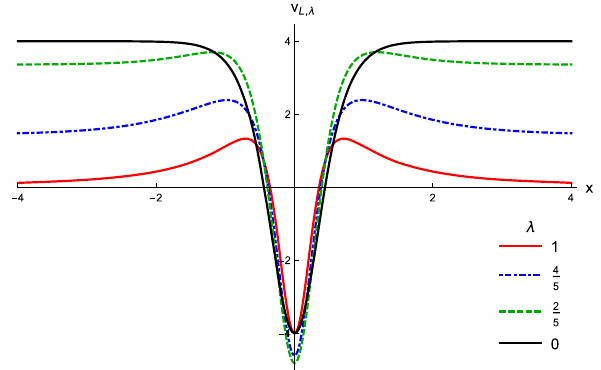
Fig. 7 The stability potential v L ,λ ( x ) given by (37) for some values of λ . When λ = 0, we have a reflectionless potential and as λ increases